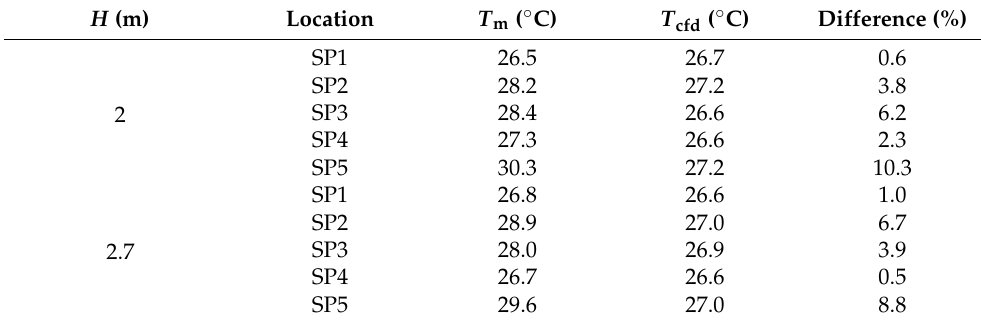
Table 3. Temperature difference between filed measurement and CFD